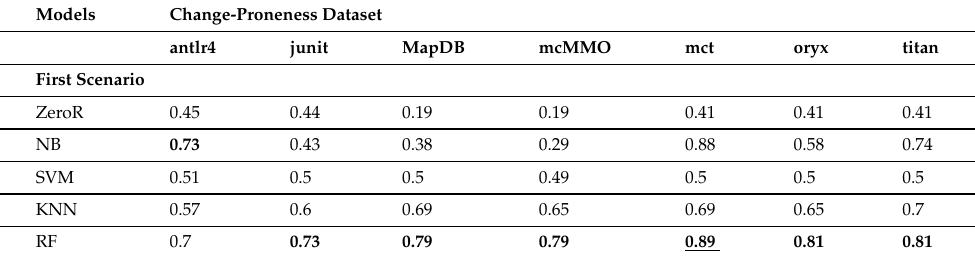
Table 12. AUC values for performance evaluation of prediction models across seven datasets in the first